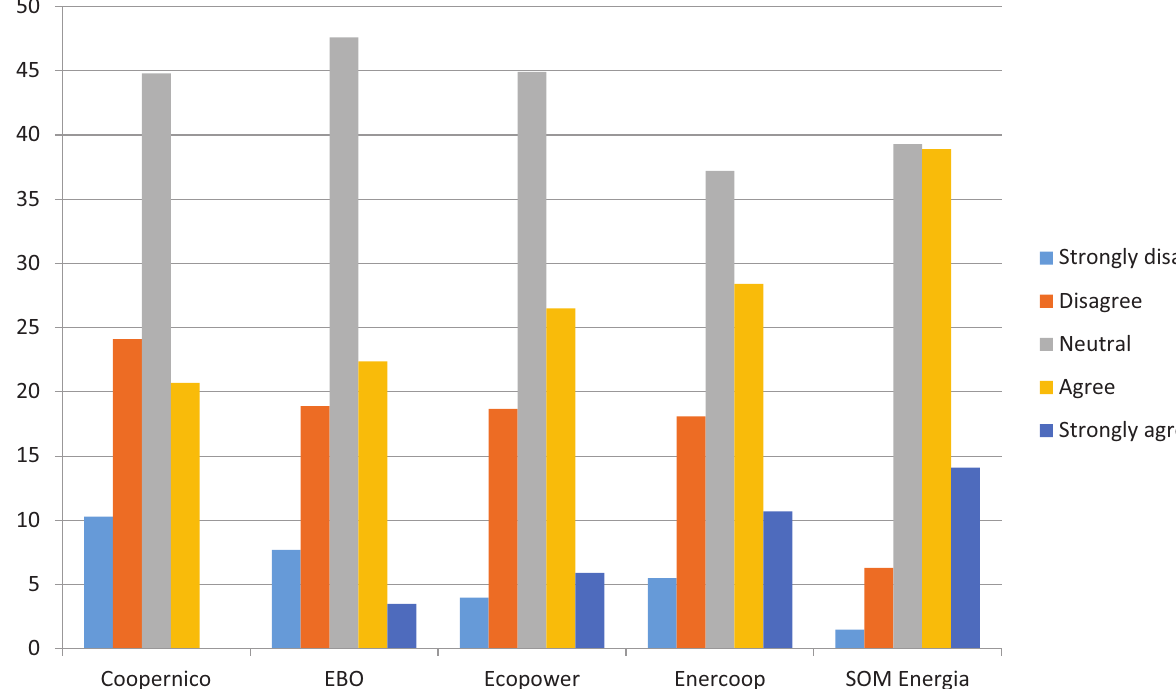
Figure 6. Response, in %, to the 2018 survey item “My REScoop has contributed to that I save more energy in my house‐ hold” by